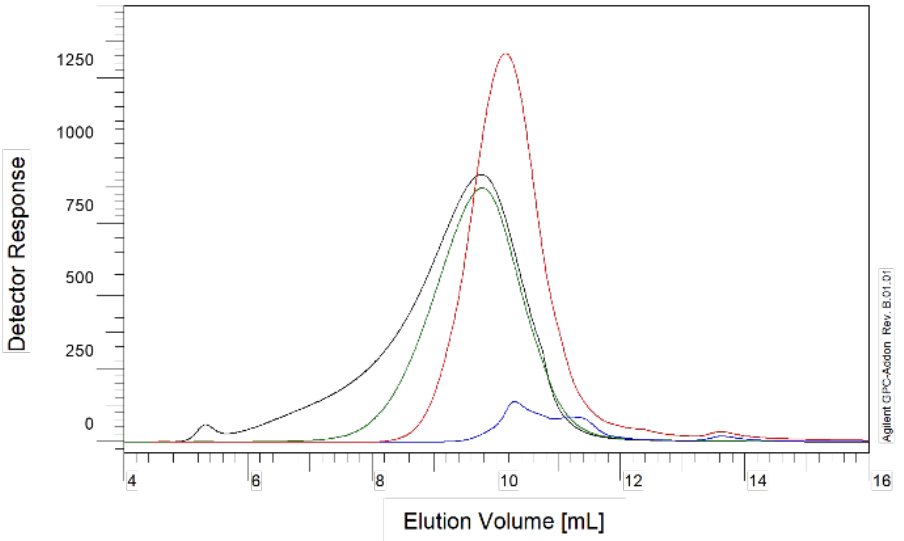
Figure 2. SEC-UV chromatograms of compounds 4aa (red line), 4af (blue line), 4ba (green line), and 4bc (black line). Sample 4af was only partially soluble in TEAN/HFIP. Table 2. Molar mass characteristics of the representative compounds 4aa , 4af , 4ba , and 4bc